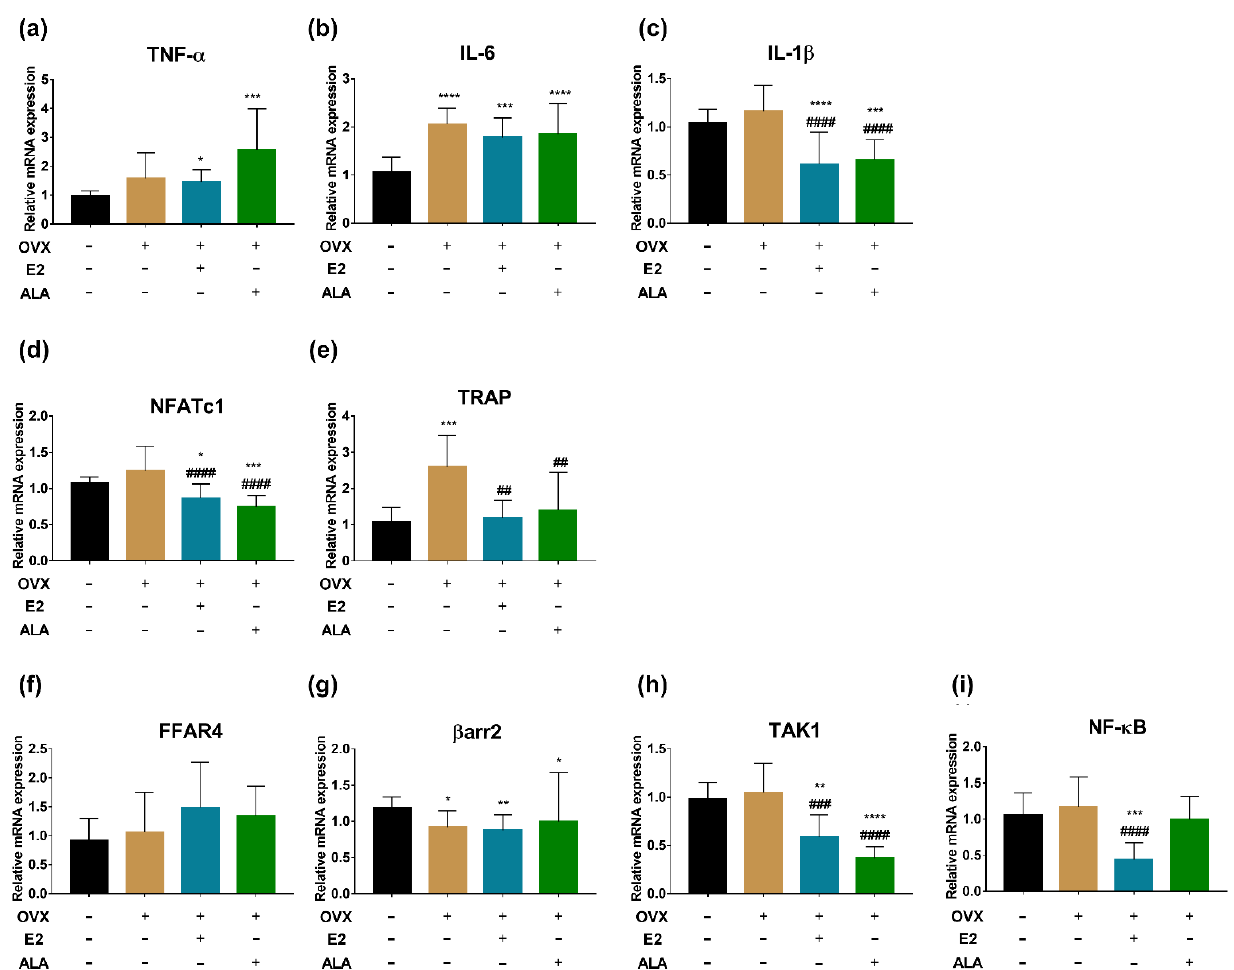
Figure 9. The expression of inflammatory factors and osteoclast genes in the bone of ovariectomized rats with ALA therapeutic treatment. ( a ) TNF- α, ( b ) IL-6, ( c ) IL- 1β, ( d ) NFATc1, ( e ) TRAP, ( f ) FFAR4, ( g ) βarr2, ( h ) TAK1 and ( i ) NF- κ B expression were measured by RT-qPCR. * p < 0.05, ** p < 0.01, *** p < 0.001, **** p < 0.0001 vs. the SHAM group (OVX (−), E2 (−), ALA (−)). ## p < 0.01, ### p < 0.001, #### p < 0.0001 vs. the OVX group (OVX (+), E2 (−), ALA (−)).